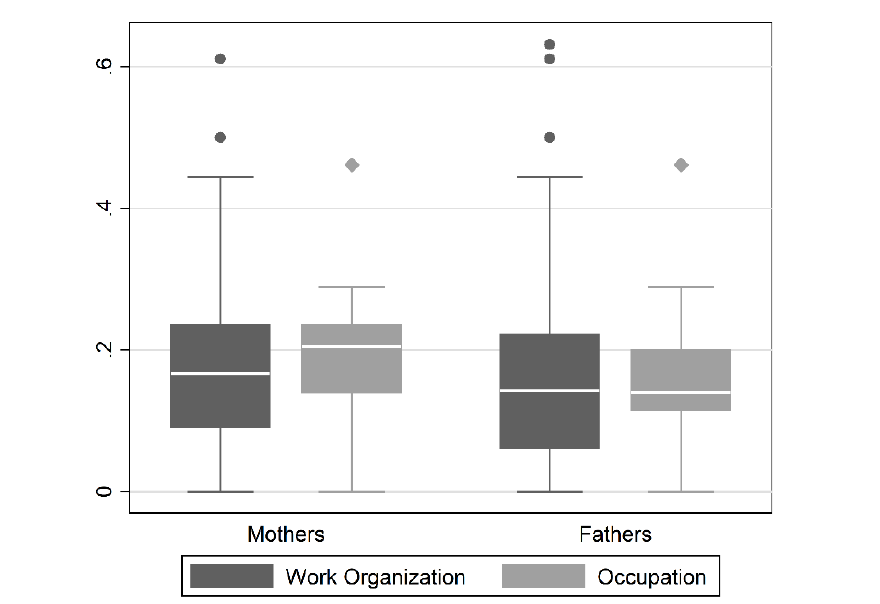
Figure 1 : Variation in mothers’ and fathers’ likelihood of reducing contracted work hours by work organization and